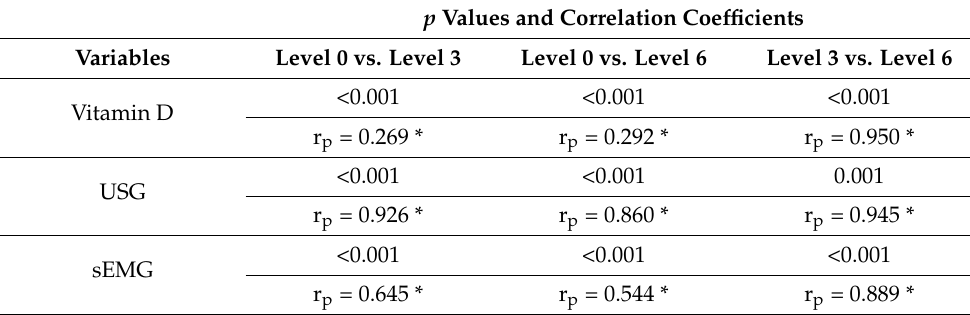
Table 6. Pairwise comparison after Friedman test and pairwise correlation.